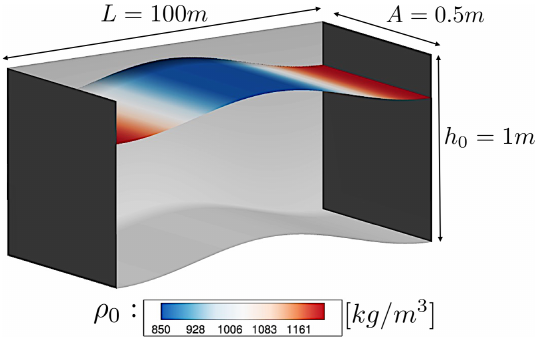
Figure B1. Dimensions and initial conditions of the rectangular tank used for the quiescent equilibrium test (Leighton et al.,